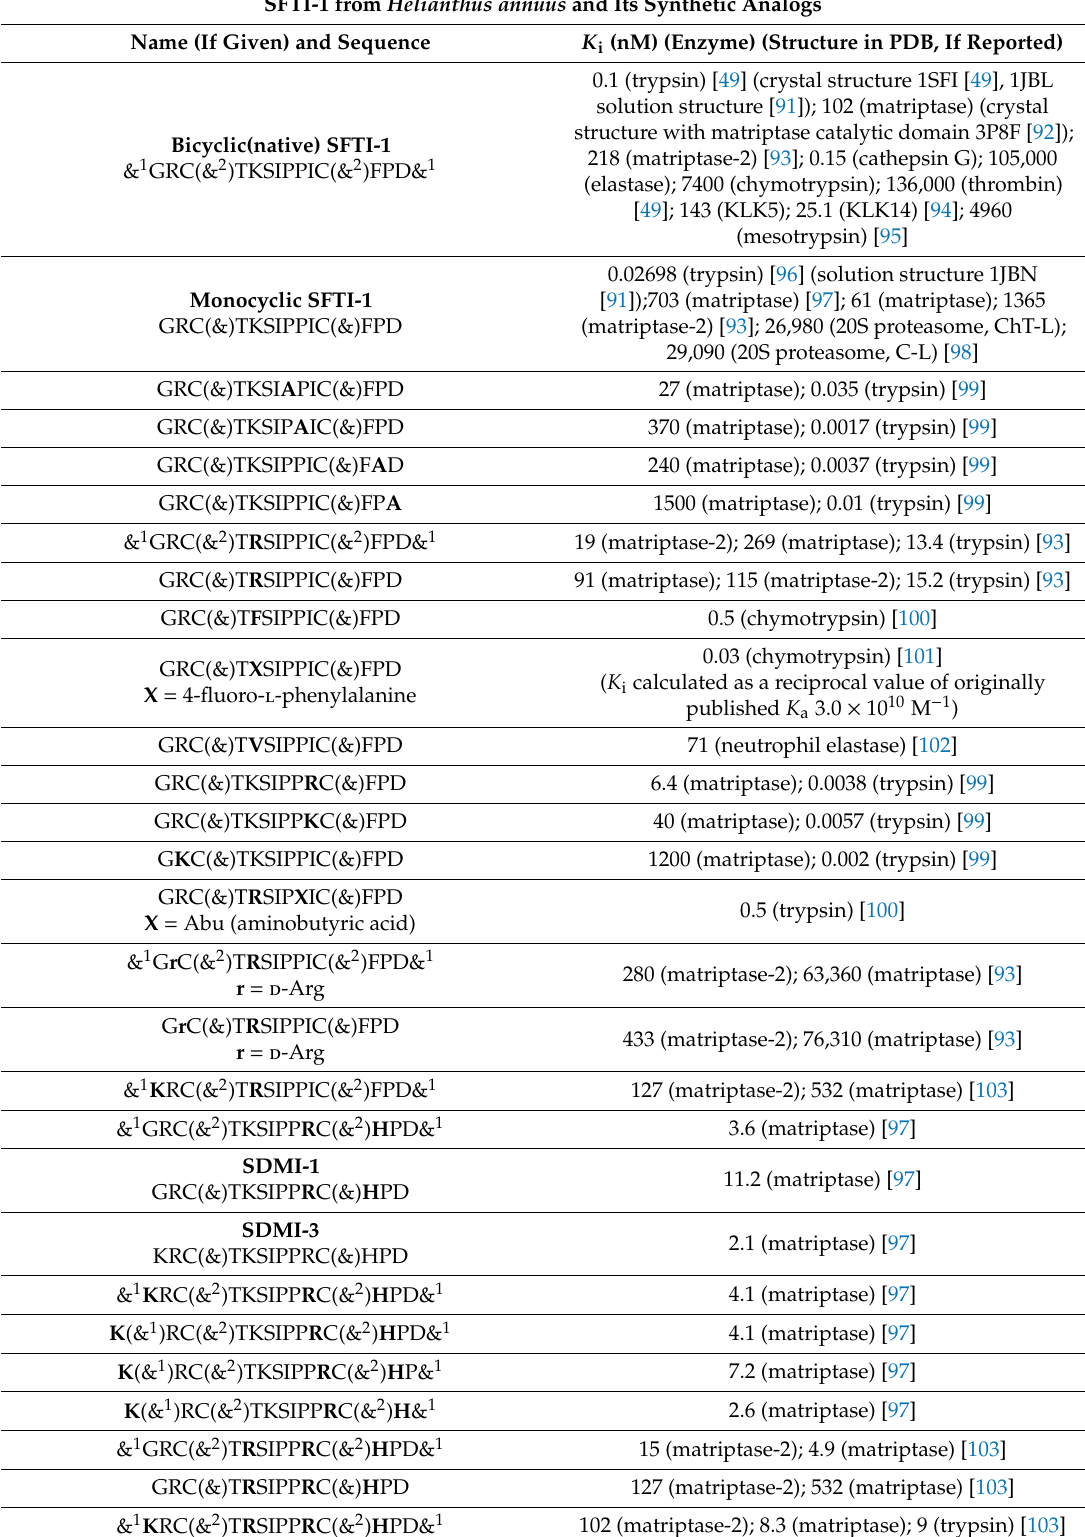
Table 2. SFTI-1 and its synthetic analogs, their inhibitory activities, and PDB codes (if available) of their crystal and / or solution structures. Modified positions are marked in bold. The cyclization is indicated by (&), according to the recommendation of Spengler et al.